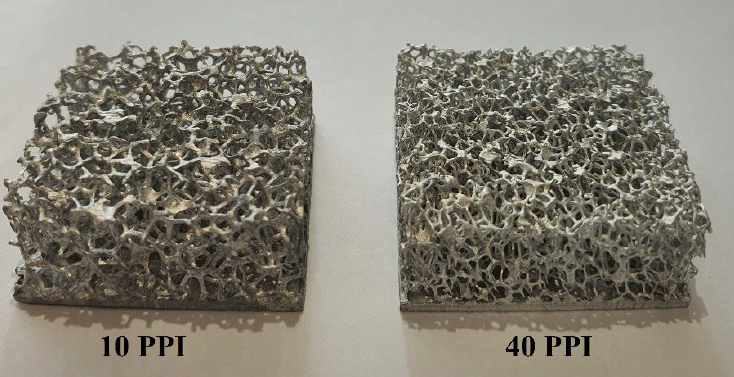
Figure 2. Appearance of aluminum PHSs with the pore density of 10 PPI and 40 PPI.